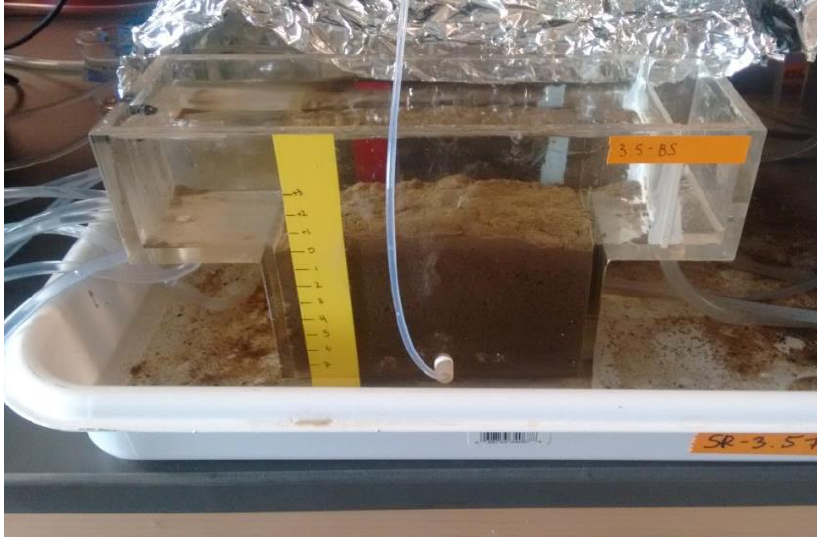
Figure 3. South River RRM3.5 Bank Sediment Mesocosm.